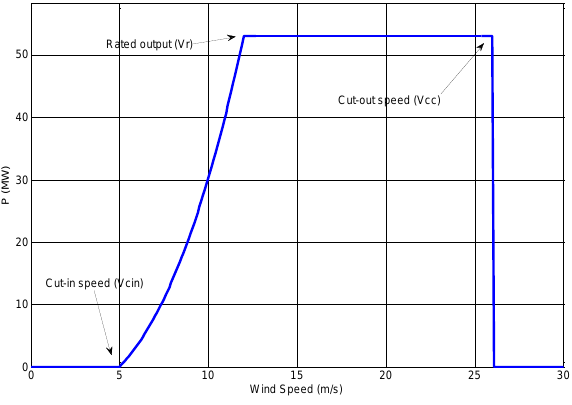
Fig. 2 . A typical curve of wind turbine